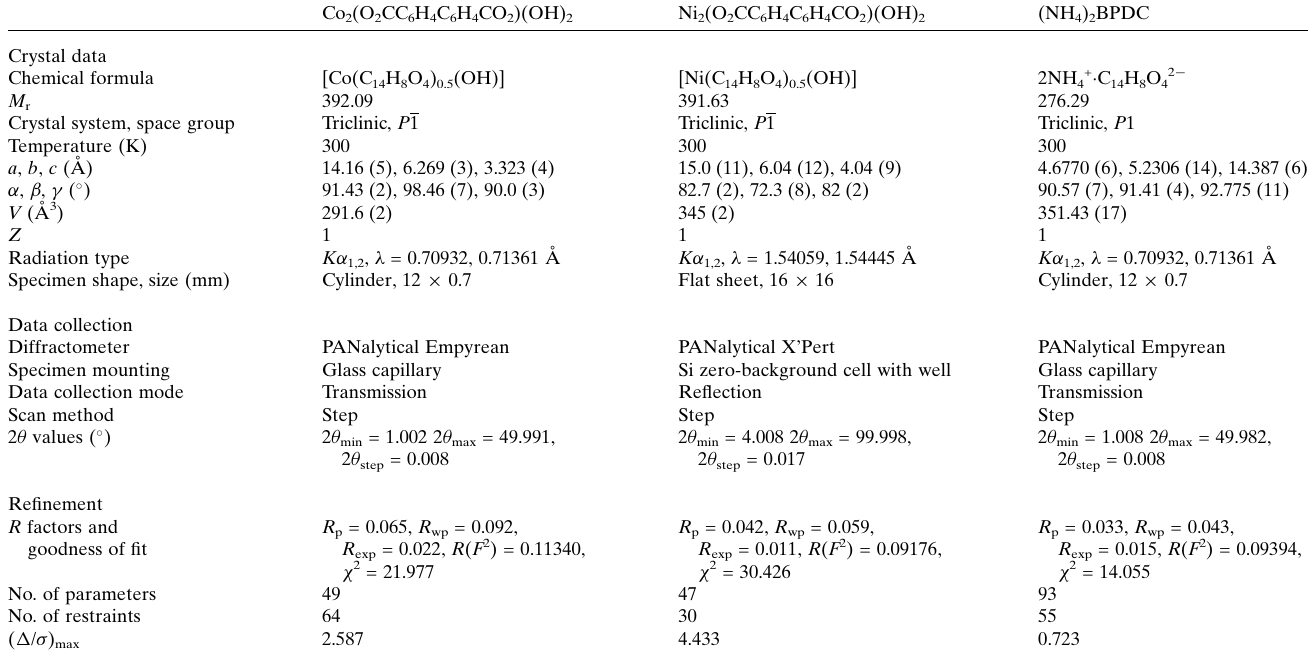
Table 2 Experimental